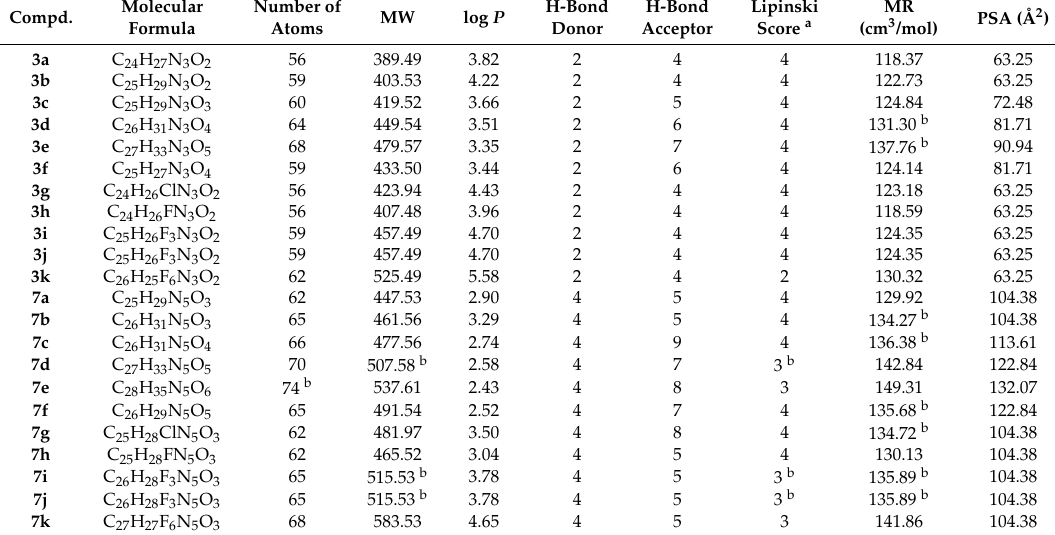
Table 1. Properties of the PQ-CAD conjugates calculated with Chemicalize.org program [54]. The Lipinski and Gelovani parameters.